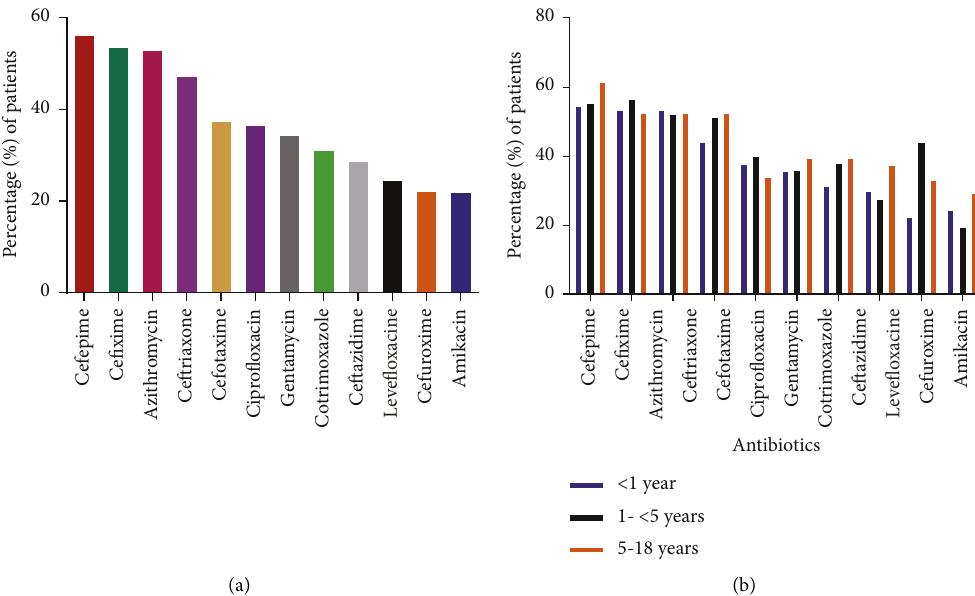
Figure 2: Response to different antibiotics regardless of the age, gender, or sample type of patients. (a) Percentages of resistance against various antibiotics among different patients; (b) antibiotic resistance among different age